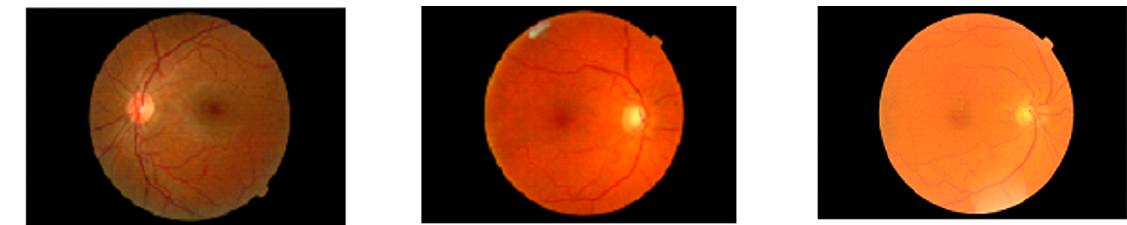
Figure 1. No DR ( left ), microaneurysms ( middle ), and hemorrhages ( right ) [19].